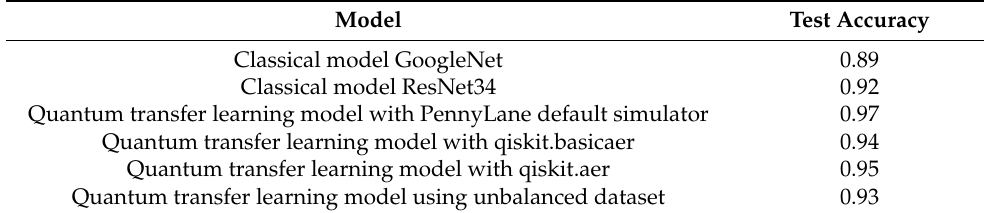
Table 6. Comparison between classical model and quantum transfer learning